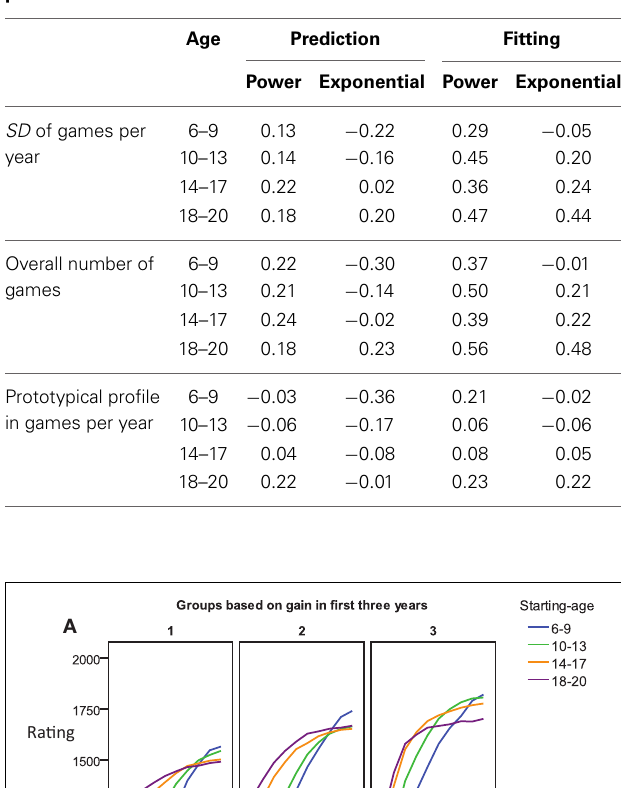
Table 4 | Spearman rank order correlations of (a) indices of regularity in numbers of games played per year with (b) the fitting and prediction error.